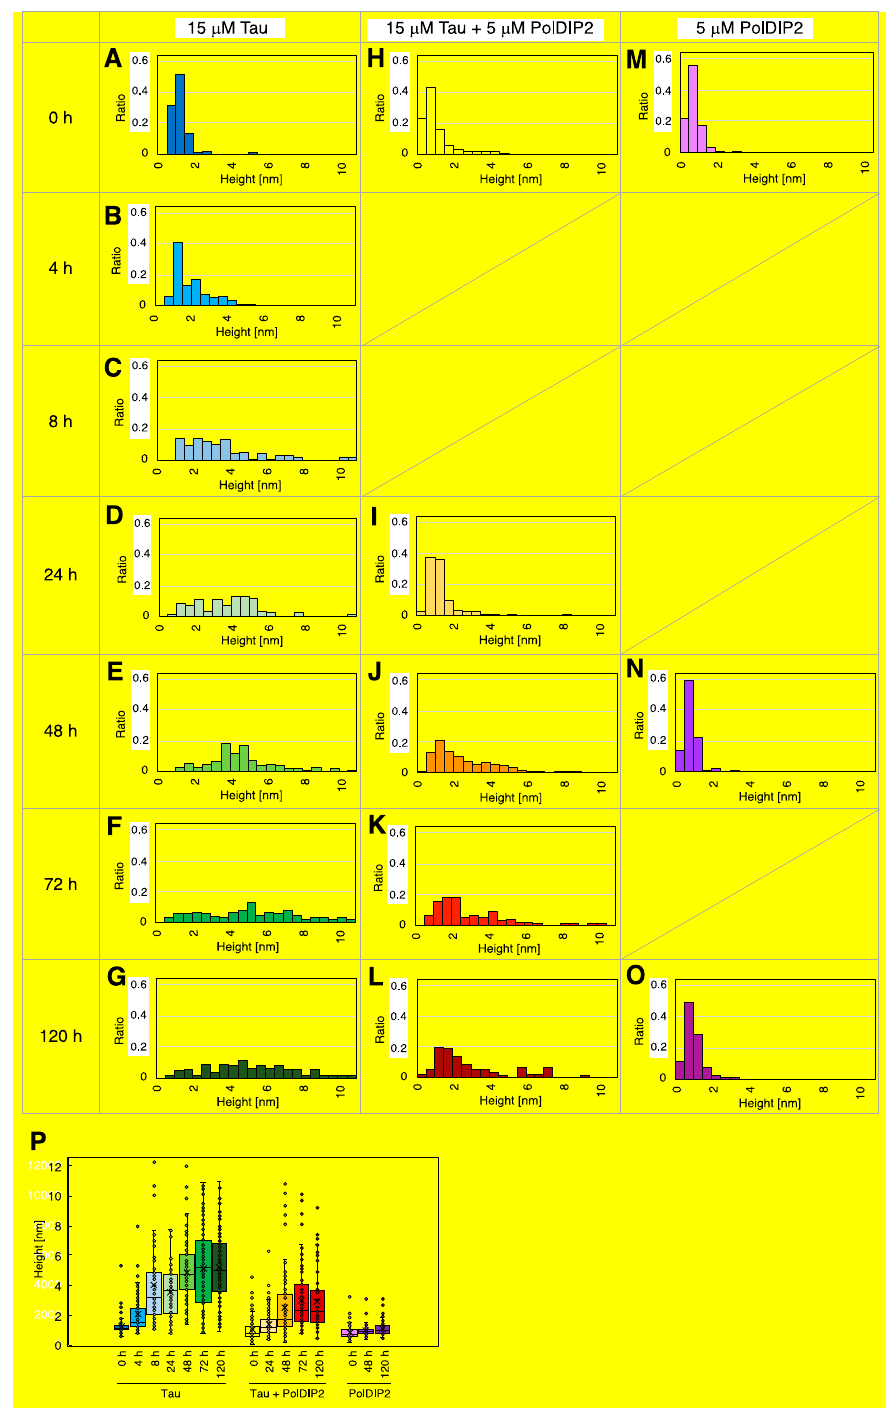
Figure 4. Tau forms globular oligomers in the presence of PolDIP2. ( A – C ) Height distribution of the fibrils or oligomers in samples with only Tau, measured in AFM cross sections at 0 h ( A ), 4 h ( B ), 8 h ( C ), 24 h ( D ), 48 h ( E ), 72 h ( F ), and 120 h ( G ); samples with PolDIP2 and Tau measured at 0 h ( H ), 24 h ( I ), 48 h ( J ), 72 h ( K ) and 120 h ( L ), and samples with only PolDIP2 measured at 0 h ( M ), 48 h ( N ) and 120 h ( O ). Distributions are presented by bar charts. ( P ) The statistical analysis of fibril and oligomer height shown in a box-and-whisker plot. The boxes represent the 25% to 75% percentiles of the data, whereas the whiskers represent the 5% to 95% percentiles of the data. The average height and median height are shown as a solid line (–) or cross (X) in the